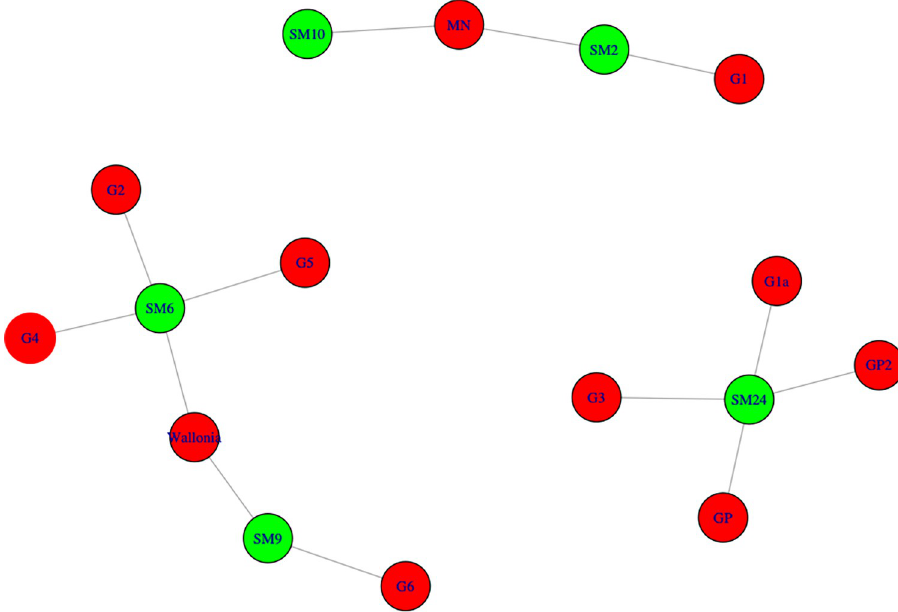
Fig 25. Network analysis of shipwrecks (in green) and provenances (in red). MN: Montagne